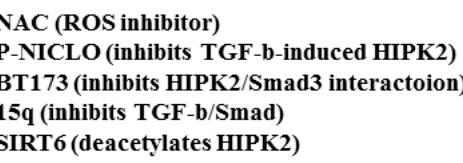
Figure 5. ( a ) HIPK2 role in kidney fibrosis. Upstream factors (HIV infection, oxidative stress-ROS) induce HIPK2 expression that consequently activates p53-dependent RTEC (renal tubular epithelial cells) apoptosis and the EMT (epithelial mesenchymal transition) markers by the pro-fibrotic pathways (Wnt/ β -catenin, TGF- β and Notch), leading to kidney fibrosis. HIPK2 is overexpressed in kidney fibrosis, FSGS (focal segmental glomerulosclerosis), diabetic nephropathy, IgA nephropathy (IgAN) and unilateral urethral obstruction (UUO). NAC (N-acetylcysteine) inhibits ROS-induced HIPK2 upregulation. Black arrows indicate activation. ( b ) Schematic representation of HIPK2 inhibitors in renal fibrosis.